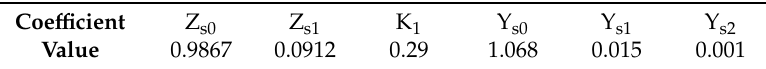
Table 5. Coe ffi cients for Objective Functions 1 and 2.